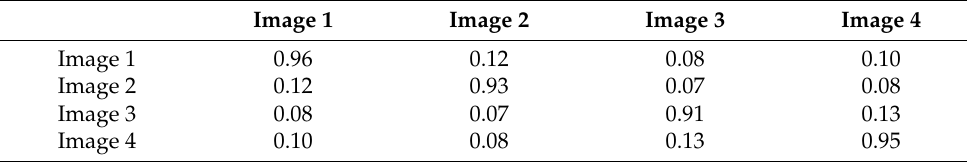
Table 3. Similarity between different images using a bag-of-words vector. Image 1